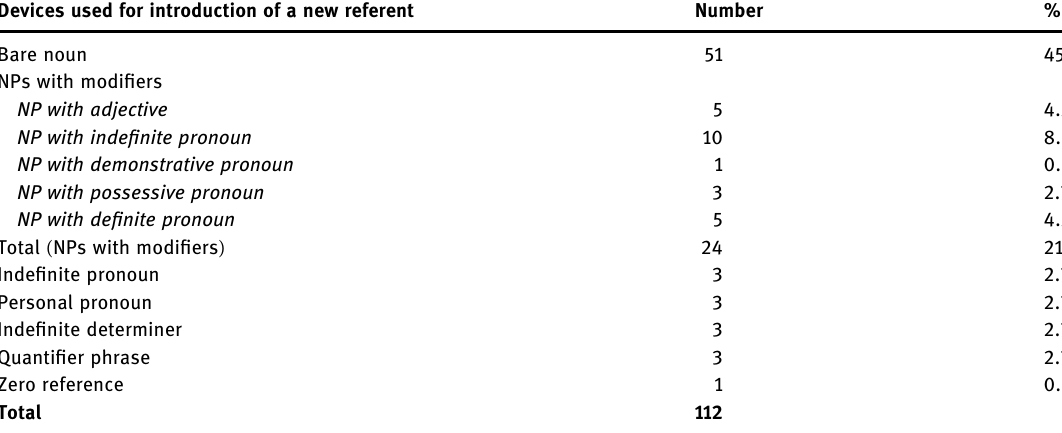
Table 2: Di ff erent devices used to introduce a new referent Devices used for introduction of a new